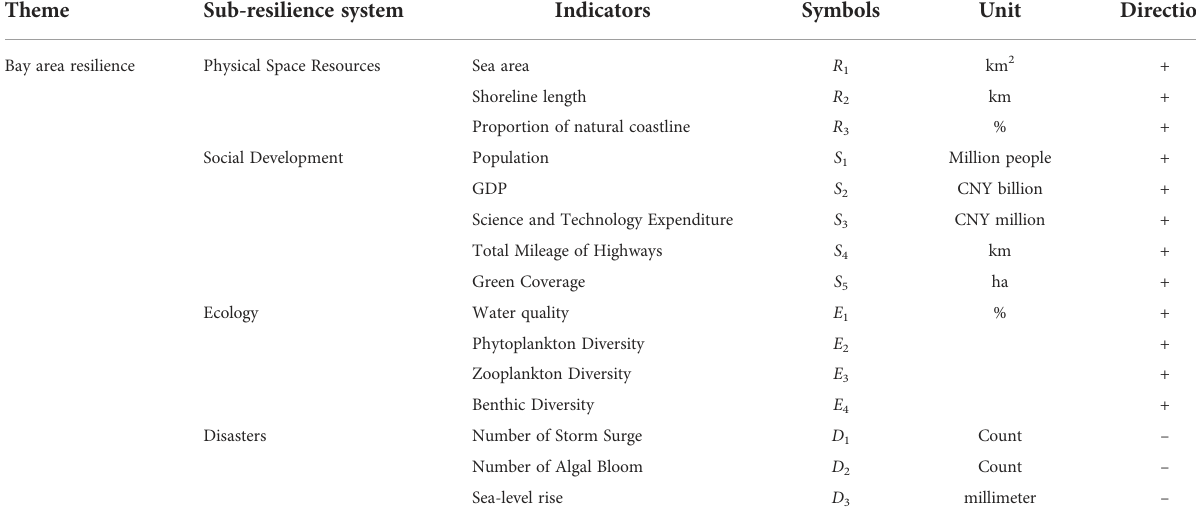
TABLE 1 Indicators for assessing the resilience of the bay area.